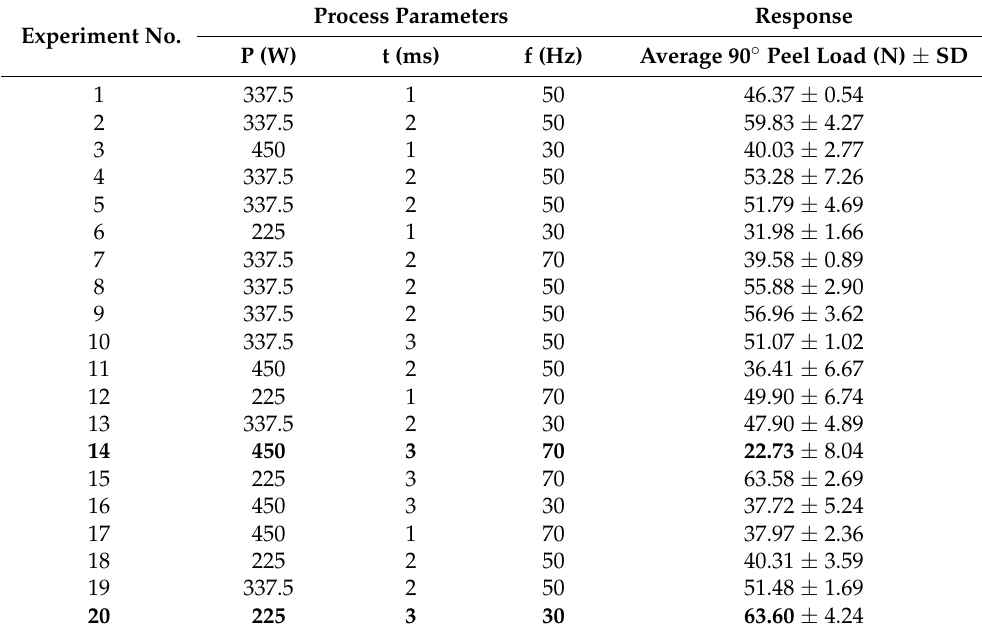
Table 4. Experimental design and measured response. Experiment